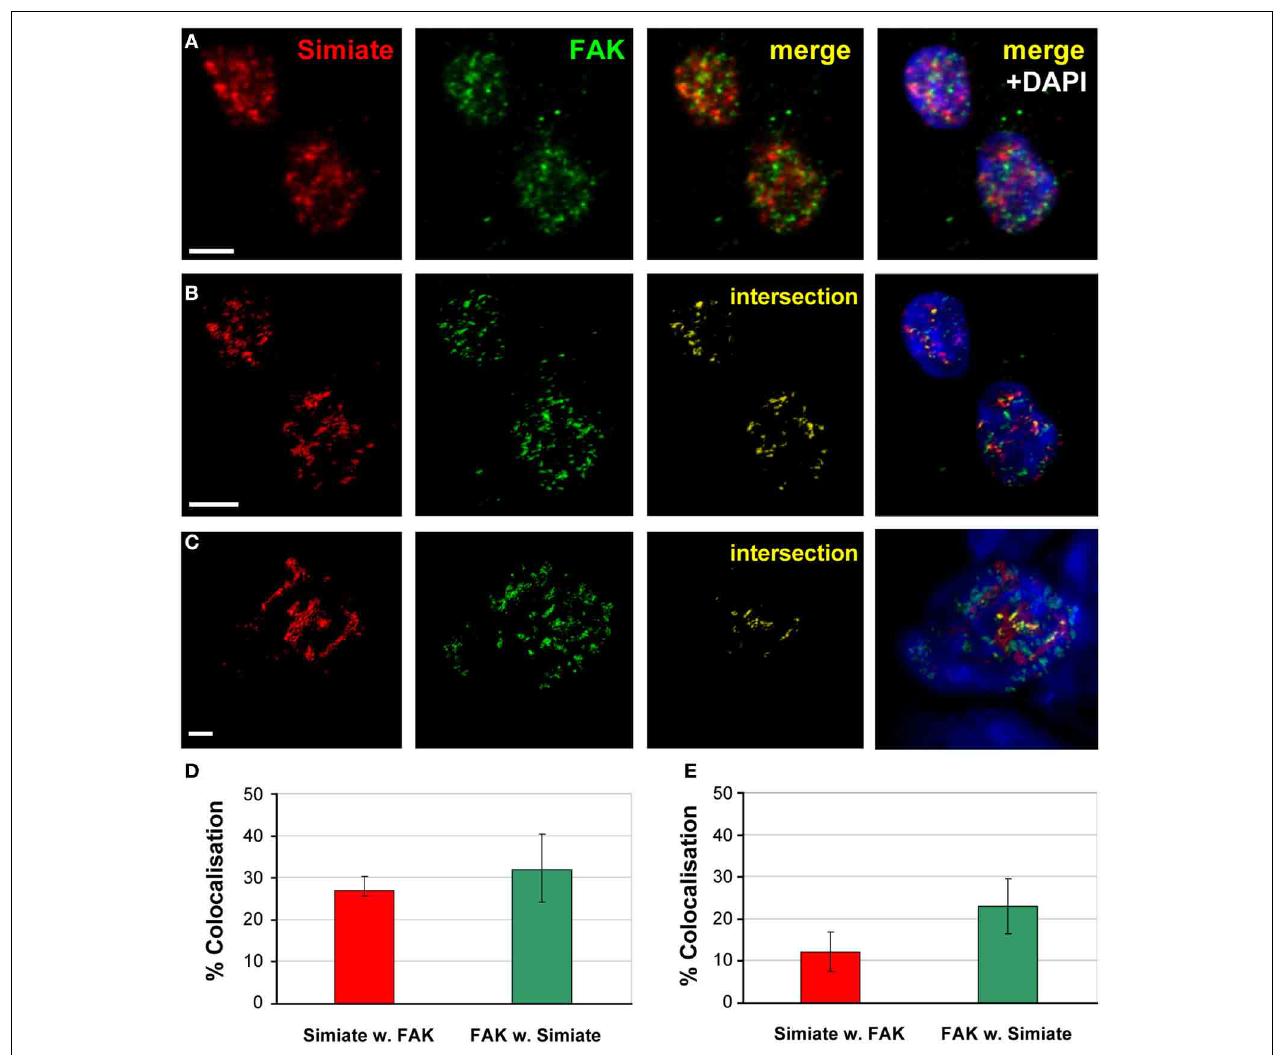
FIGURE 8 | Simiate and FAK colocalize in the nucleus. (A) Z-Projections of stacks taken from immunofluorescent labeled HEK-293 cells. Scale bar: 5 μ m. (B) 3D-reconstruction of Simiate and FAK as shown in (A) . (C) 3D-reconstruction of Simiate and FAK in the nucleus of a pyramidal neuron